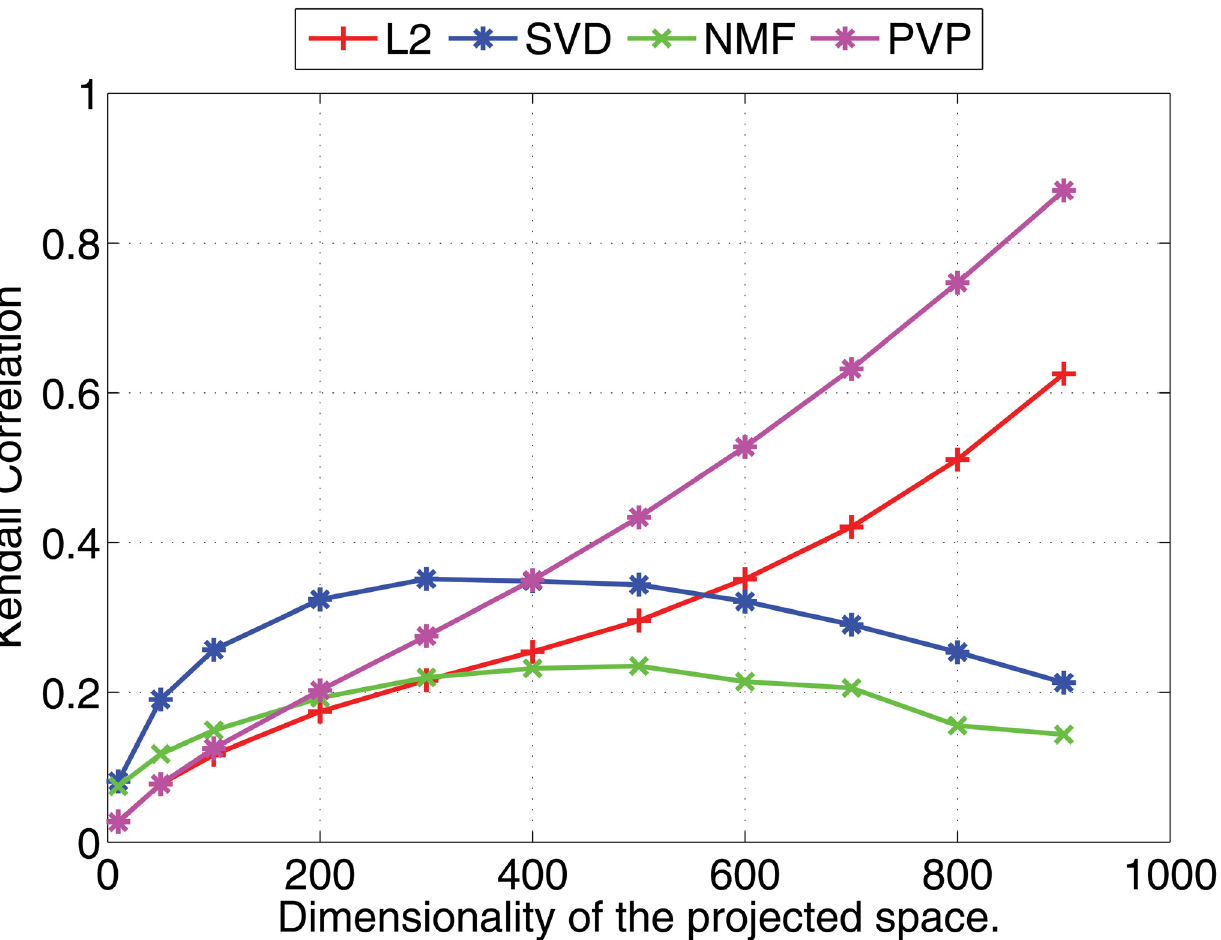
Fig 4. Nearest neighbor prediction with artificial data. Kendall ’ s τ (right) correlation coefficients for different dimensionality reduction methods are shown under varying dimensionalities (Feature vectors are 10000